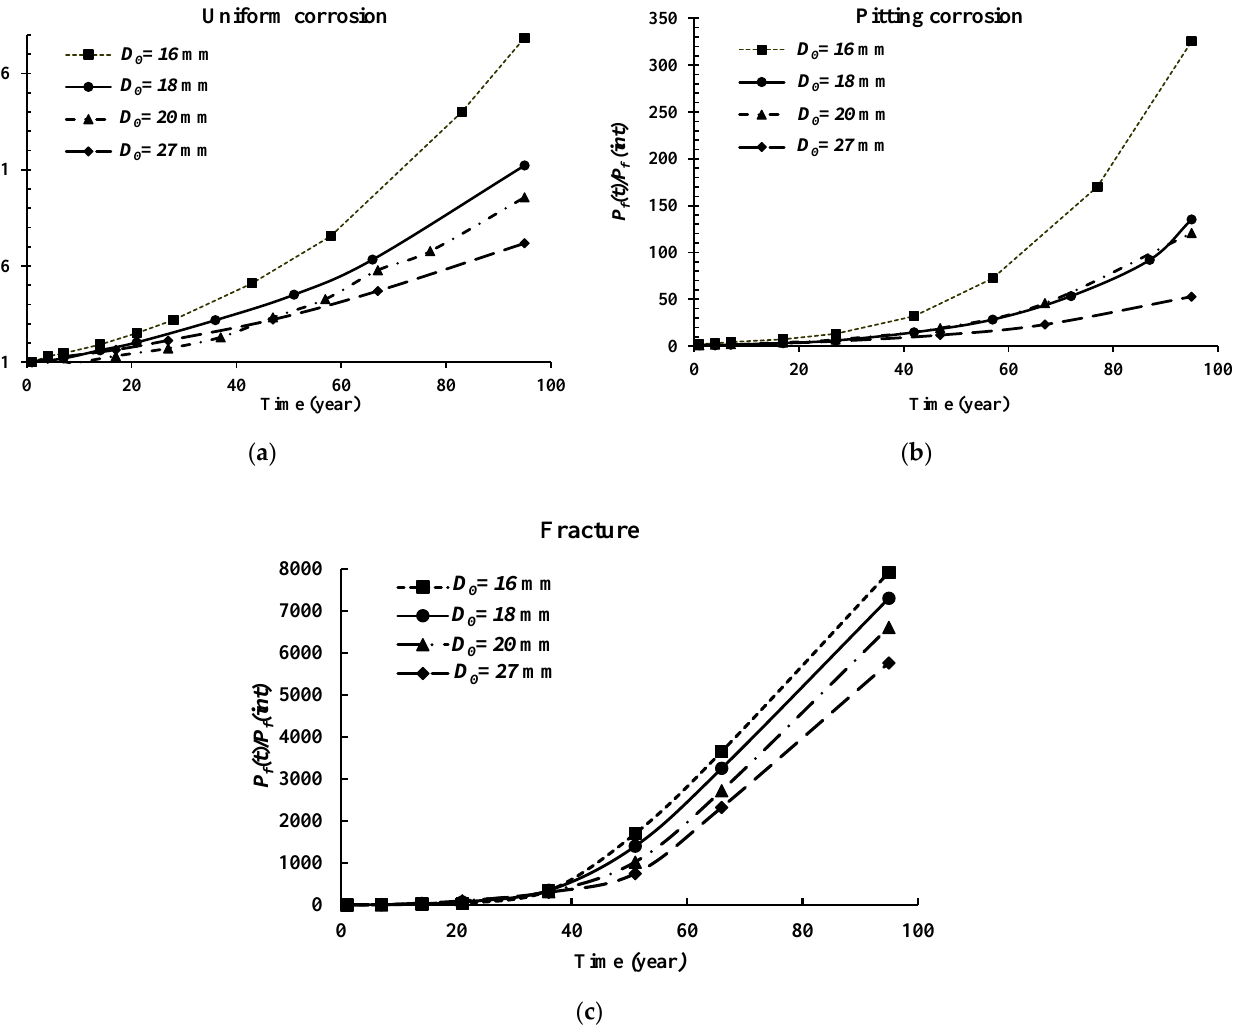
Figure 4. Influence of the nominal diameter of the bar ( D 0 ) on the reliability analysis results for the ( a ) uniform corrosion form, ( b ) pitting corrosion form, and ( c ) fracture failure mode.